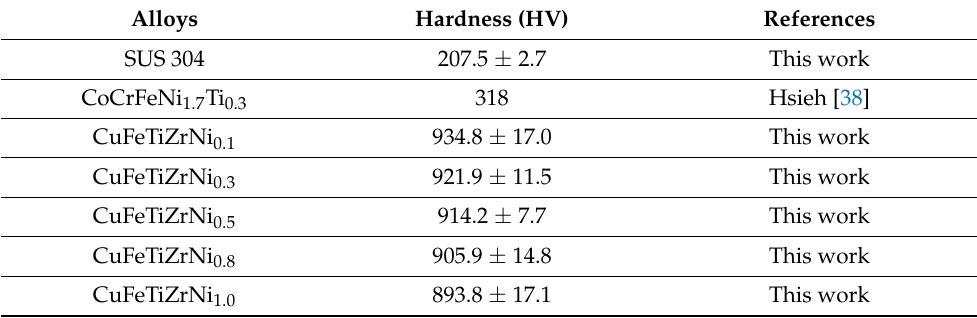
Figure 5. The hardness (HV) values of the CuFeTiZrNi x alloys, CoCrFeNi1.7Ti 0.3 [34], and SUS 304. Table 3. The measured hardness values of the CuFeTiZrNi x alloys and SUS 304.